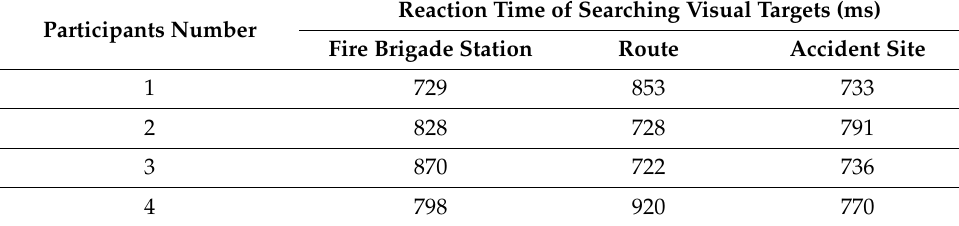
Table A2. The Reaction Time of Group B (Figure 4b